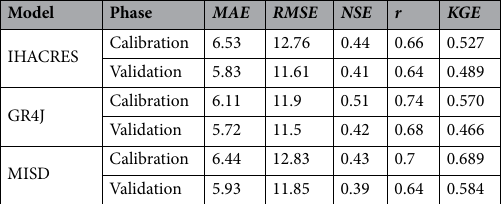
Table 6. The results of the applied metrics over different white-box